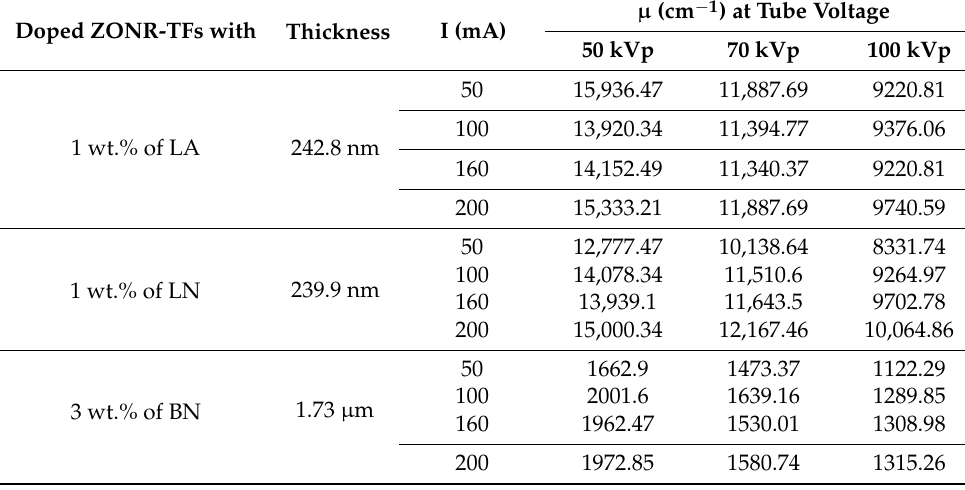
Table 4. Measured values of µ (cm − 1 ) for optimum LA-, LN-, and BN-doped ZONRs-TFs at different X-ray photon energies and tube currents. Doped ZONR-TFs with